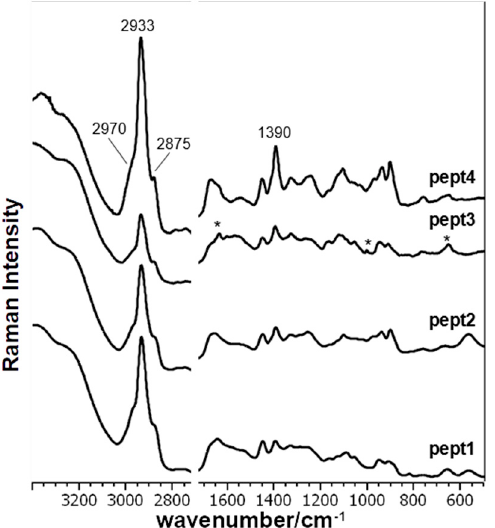
Figure 1. SERS spectra of the examined peptides (Pept2, Pept3, and Pept4) at 10 − 5 M concentration compared with the EAK parent peptide (Pept1). Asterisks (*) were used to indicate the bands attributed to FMOC used in the synthesis procedure.